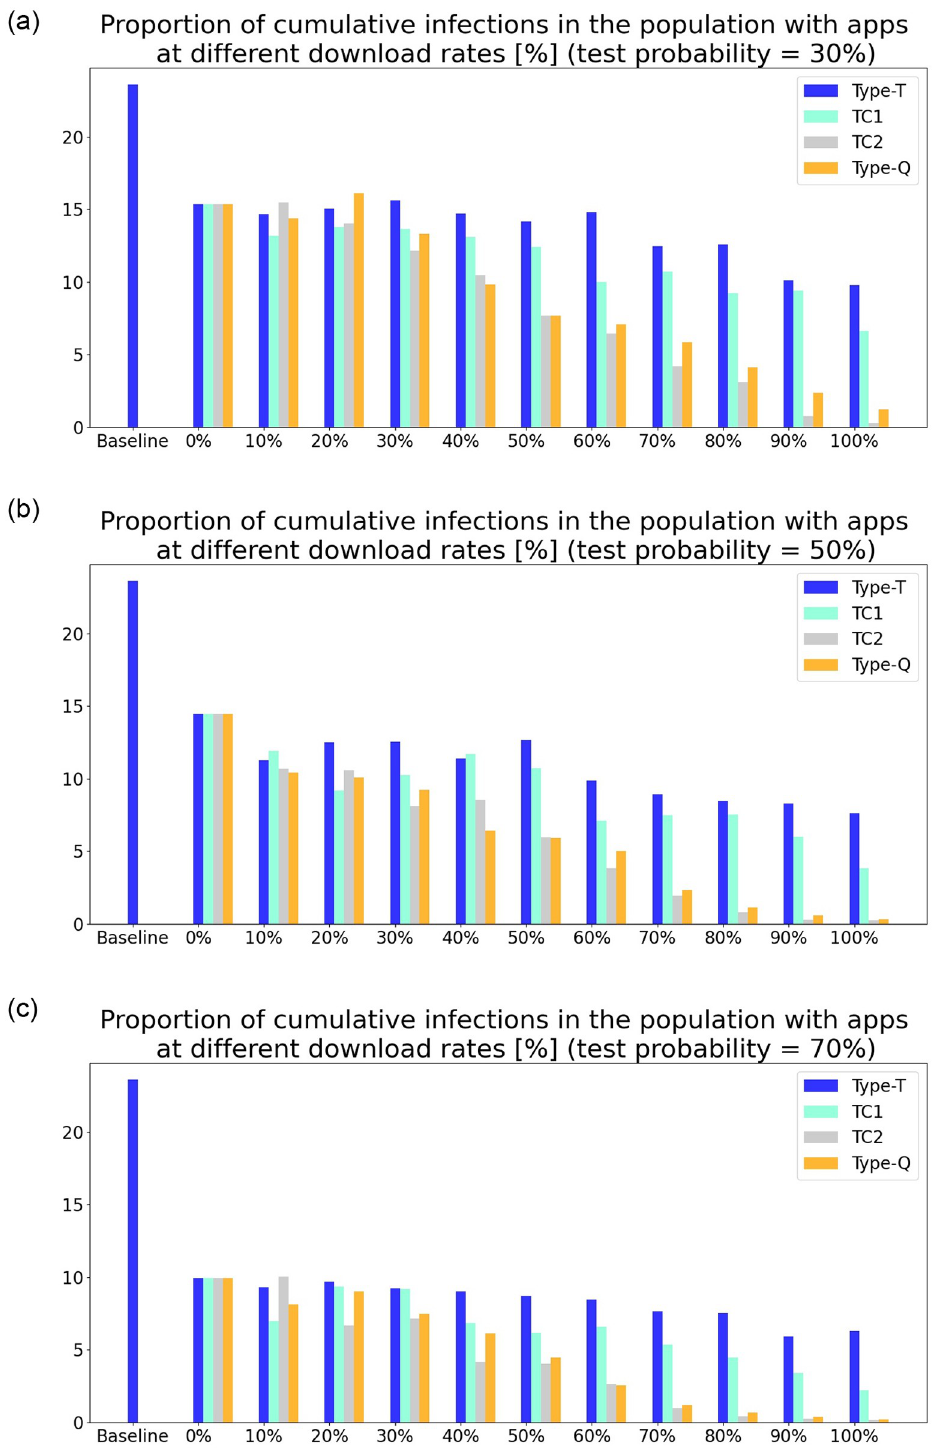
Fig 3. Proportion of cumulative number of infections in the population under different scenarios. (a) Scenario of 30% test probability. (b) Scenario of 50% test probability. (c) Scenario of 70% test probability.